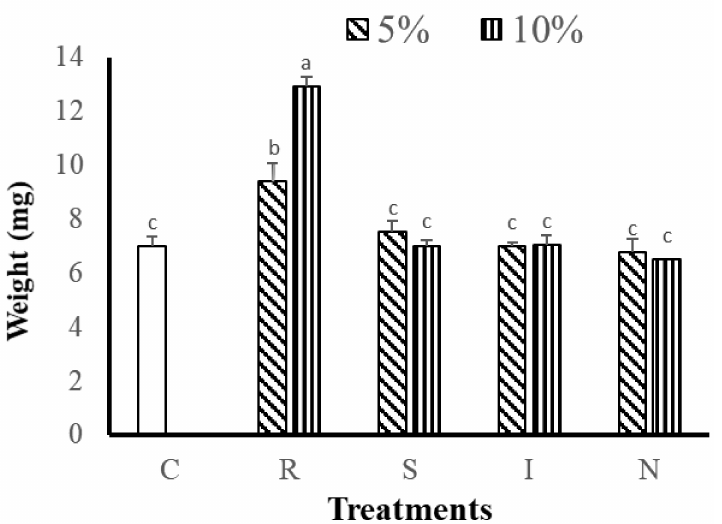
Figure 1. Tissue and skeletal dry weight of G. columna after 8 weeks of daily feeding with various aquaculture feeds. C: no feeding; R: artificial polyunsaturated fatty acid (PUFA) rich in animal protein; S: Saccharomyces cerevisiae ; I: Isochrysis galbana tml; N: Nannochloropsis oculata . Different